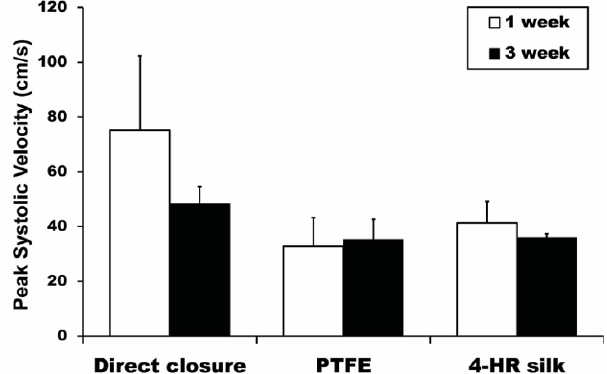
Figure 6. One-week and three-week post-angioplasty peak systolic velocity (PSV) results for all three groups. One-week post-operation results yielded a statistically significant difference among all groups ( p = 0.007). The PSVs for the 4-HR silk and PTFE groups were significantly different than that for the control group ( p = 0.005). Three-week post-operation results yielded a statistically significant difference among all groups ( p = 0.029). The control group PSV result was significantly different from